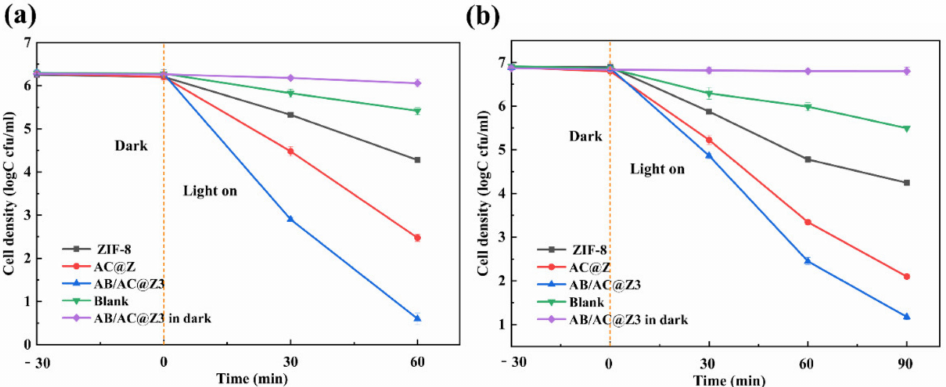
Figure 8. ( a ) Survival curves of E. coli treated with different catalysts under the simulated sunlight. ( b ) Survival curves of P. aeruginosa treated with different catalysts under the simulated